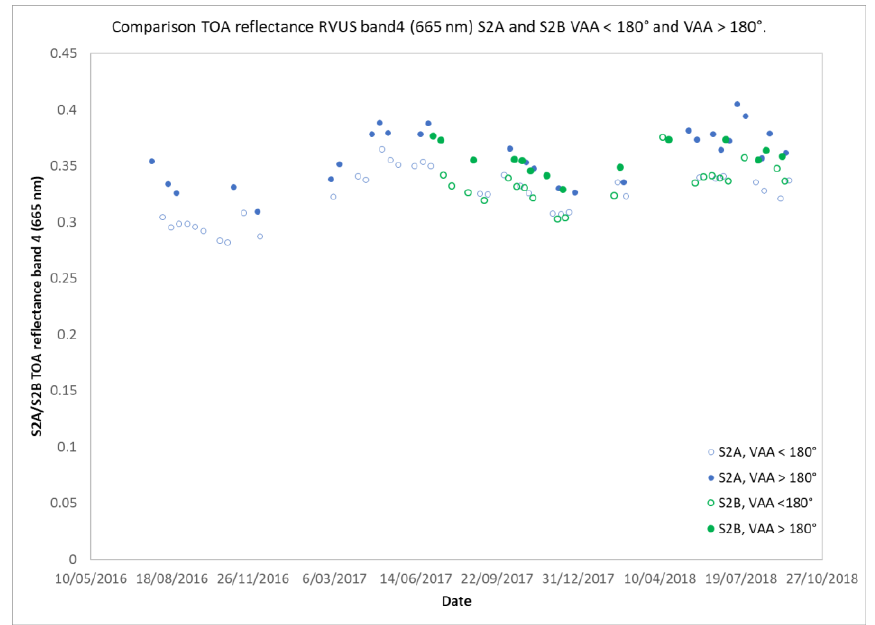
Figure 7. TOA measured B4 (0.665 µm) reflectance values of S2A (blue dots) and S2B (green dots) over the RVUS site. A distinction is made between observations with VAA < 180° (open circles) and with VAA > 180° (filled circles).